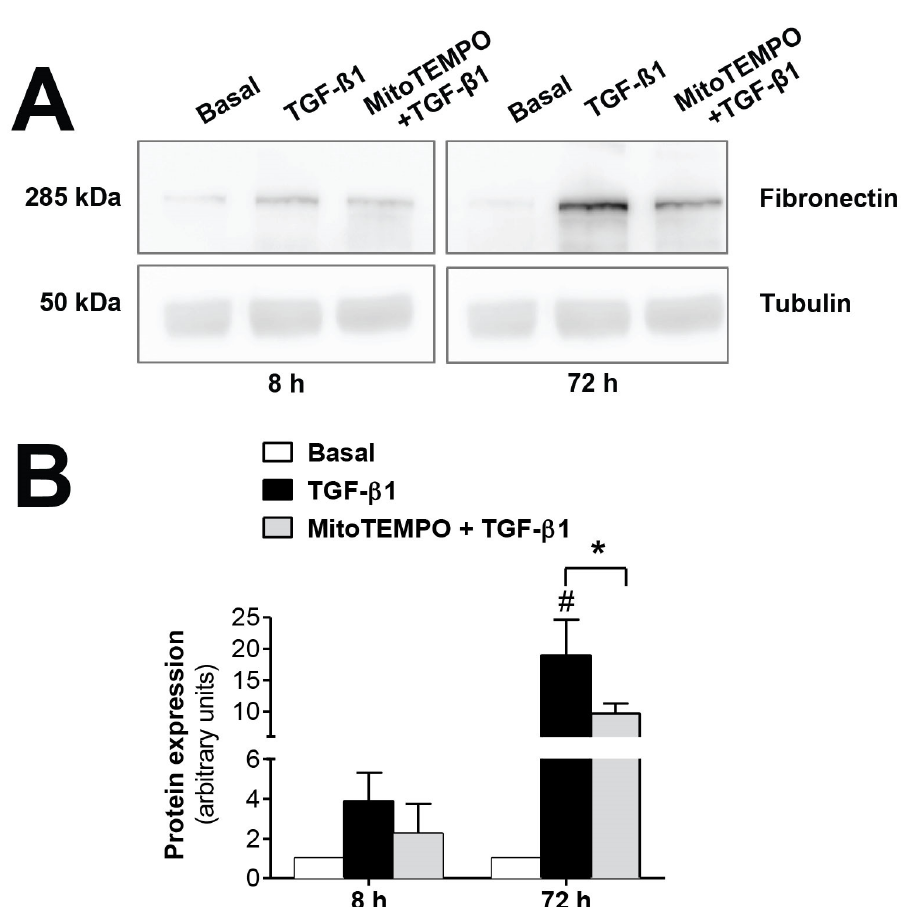
Figure 3. Modulatory effects of MitoTEMPO on TGF- β 1-induced epithelial-to-mesenchymal tran- sition (EMT) in omentum-derived mesothelial cells. ( A ) Representative Western blot analysis of fibronectin expression at 8 and 72 h in TGF- β 1-treated mesothelial cells with and without Mito TEMPO pretreatment and ( B ) quantification expressed in arbitrary units. Bars represent the fold induction over untreated cells as means ± SEM of three independent experiments. * p < 0.05 vs. TGF- β 1 and # p < 0.05 vs. Basal. PD: peritoneal dialysis; EMT: epithelial-to-mesenchymal transi- tion.